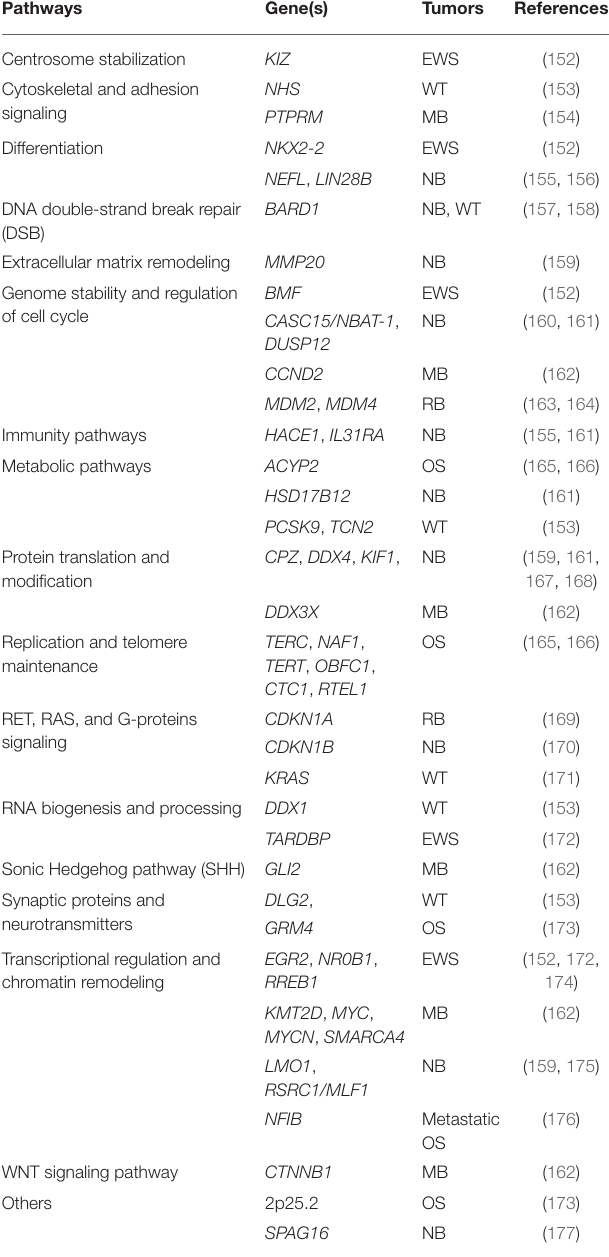
TABLE 3 | Common, low-penetrance variants in genes predisposing to pediatric tumors and main biological pathways.